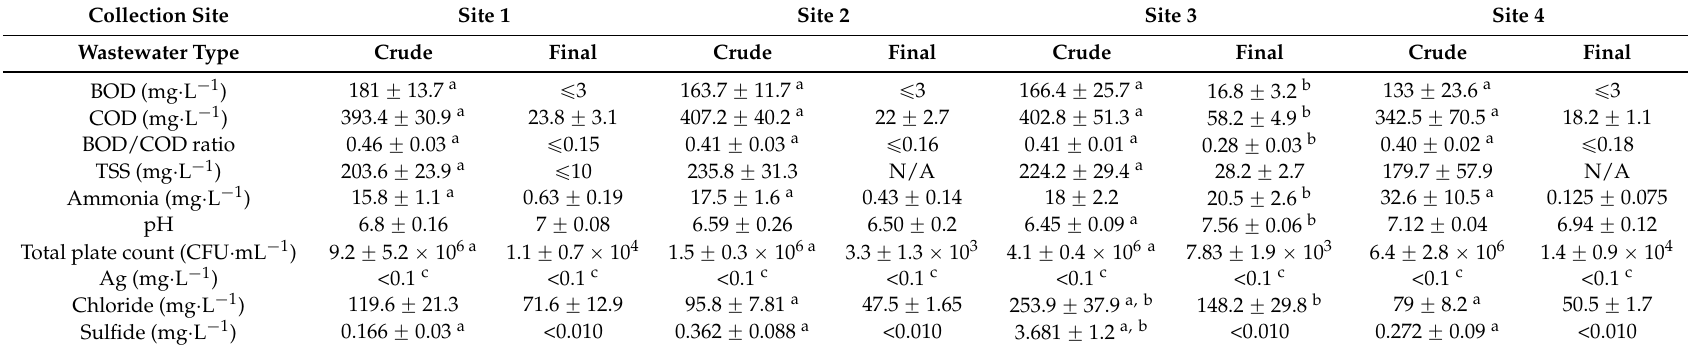
Table 1. Physicochemical and microbiological parameters of used wastewaters. Data are mean ˘ SEM (n =